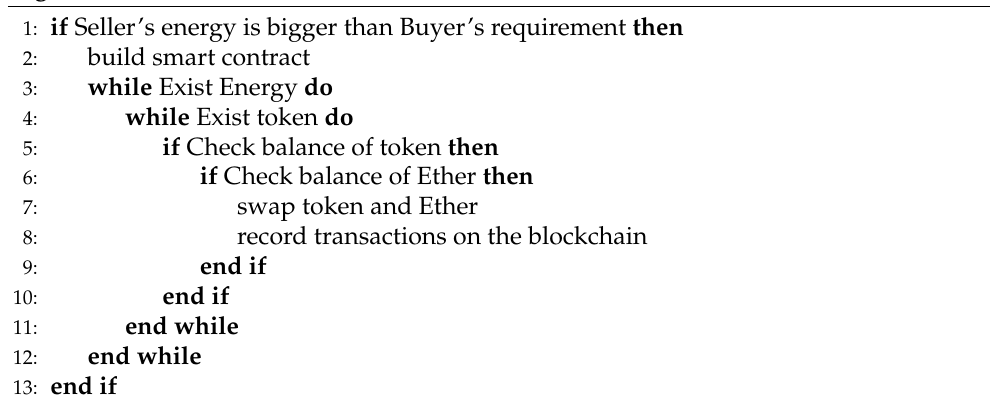
Algorithm 2 Transaction Condition in Smart Contract.